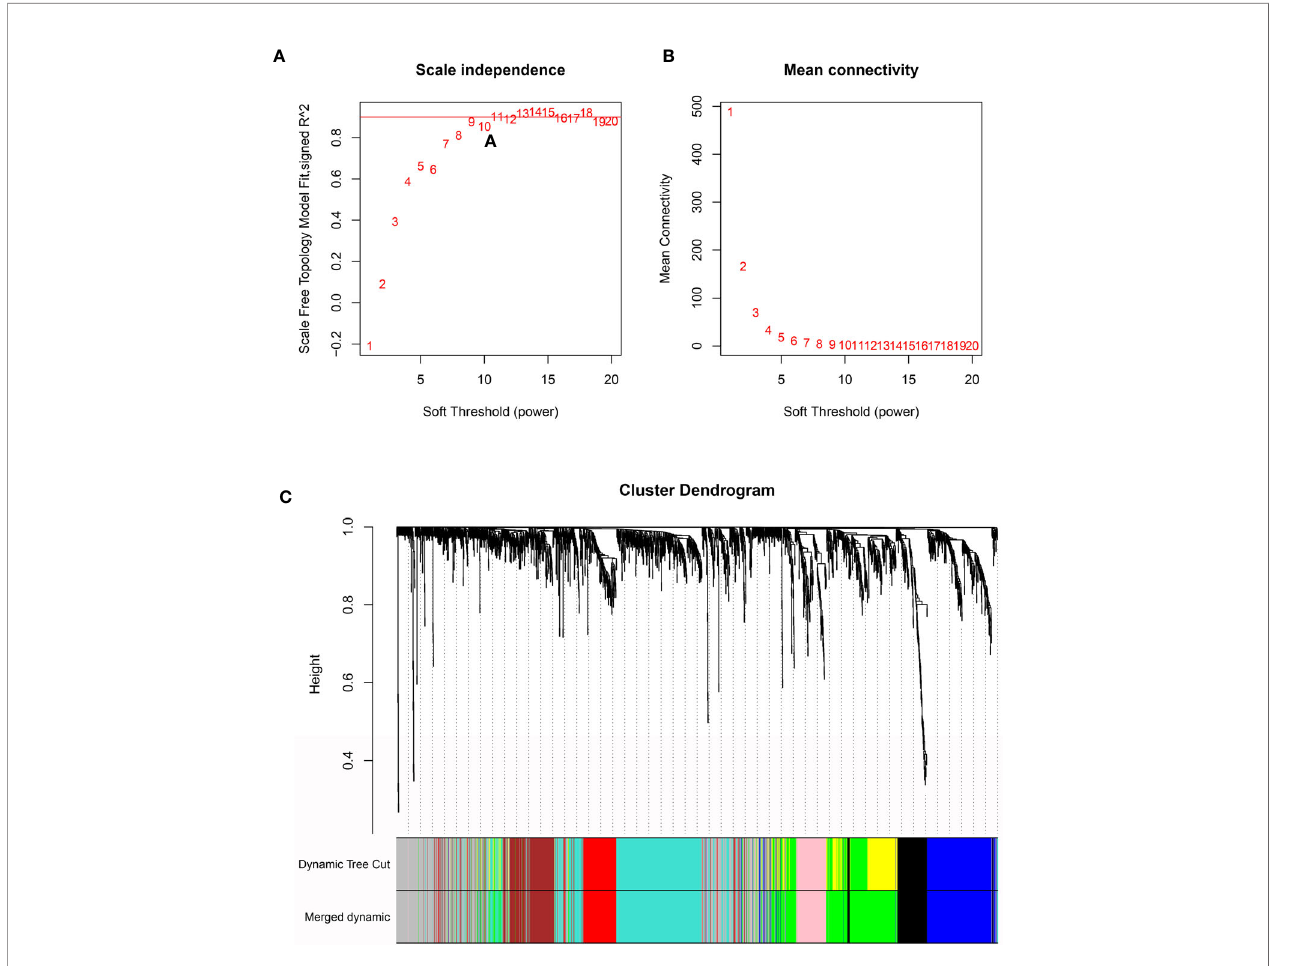
FIGURE 3 | WGCNA-based identi fi cation of 8 independent gene modules based on PDAC transcriptome data. (A, B) An appropriate b value was selected to increase the similarity matrix and obtain a scale-free coexpression network. (C) Eight gene modules remained after adjacent gene modules with high similarity were